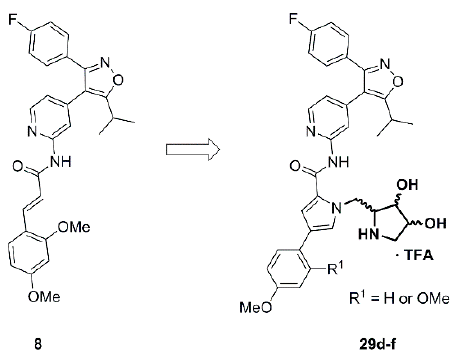
Scheme 1. Inhibitor design concept. Based on protein kinase CK1 δ inhibitor 8 the cinnamic acid side chain was modified to attach chiral pyrrolidine